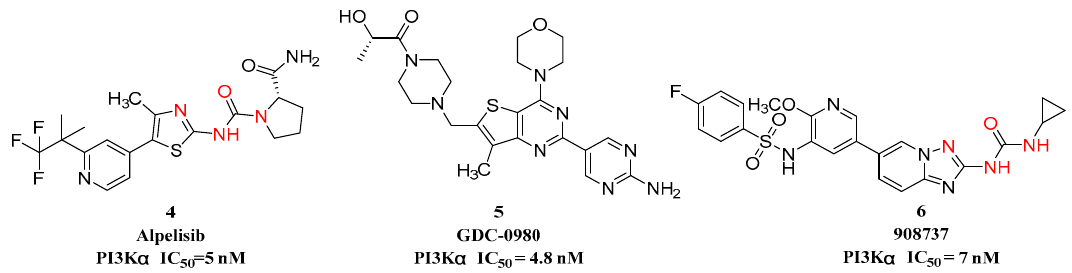
Figure 2. Structures of representative PI3K inhibitors.